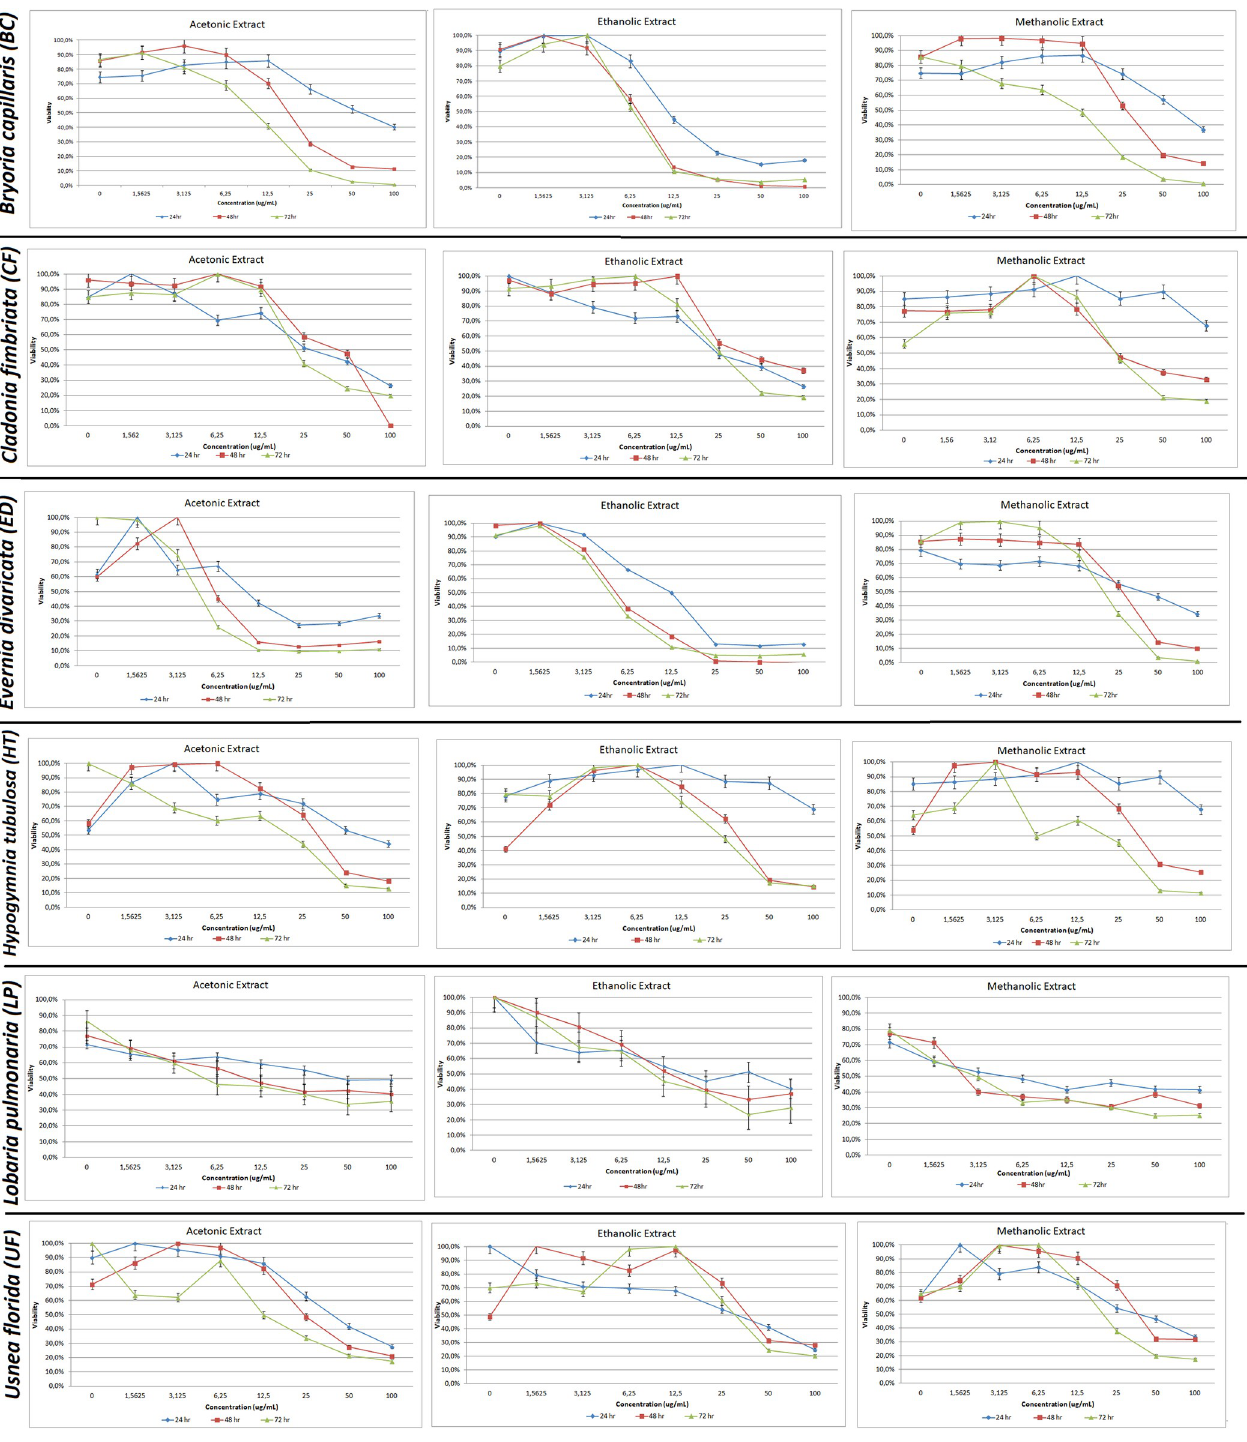
Fig 2. Cell viability by 3-(4,5-dimethylthiazol-2-yl)-2,5-diphenyltetrazolium bromide (MTT) assay. PC-3 cells were treated with acetone, ethanol and methanol extracts of Bryoria capillaris , Cladonia fimbriata , Evernia divaricata , Hypogymnia tubulosa , Lobaria pulmonaria , and Usnea florida at 24, 48, 72